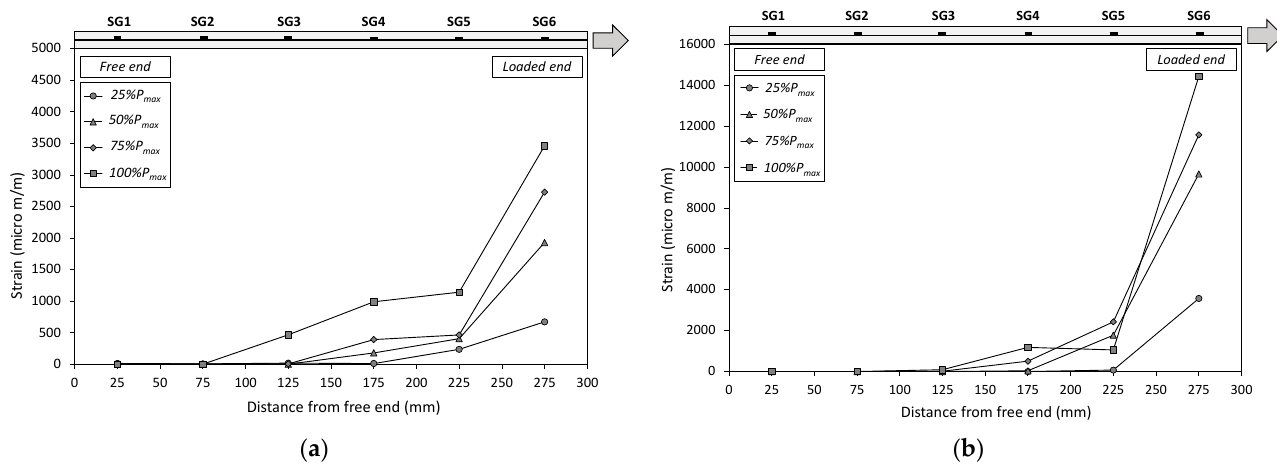
Figure 8. Longitudinal fabric strain profile along the bonded length: ( a ) specimen CM-300; ( b ) specimen GM-300.